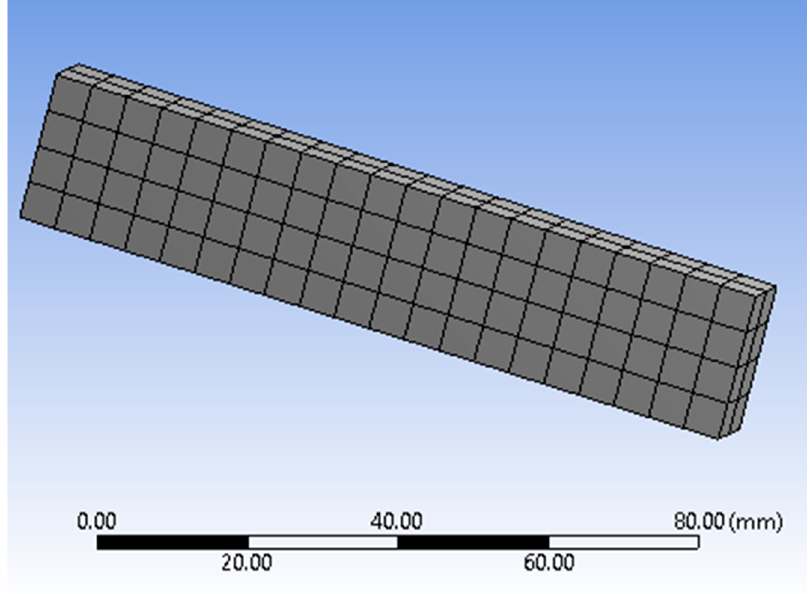
Figure 2. Domain and mesh distribution.